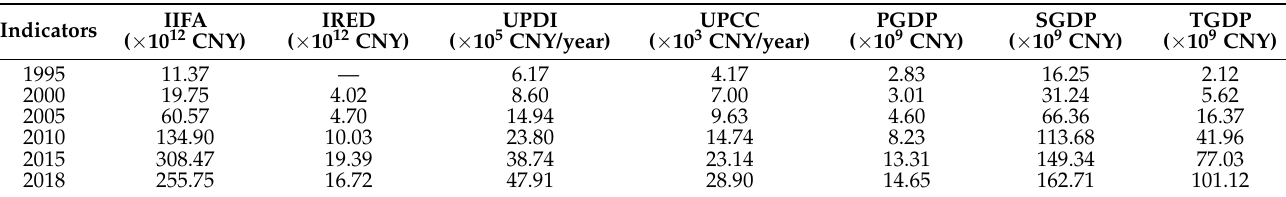
Table 6. Dongying socioeconomic indicators from 1995 to